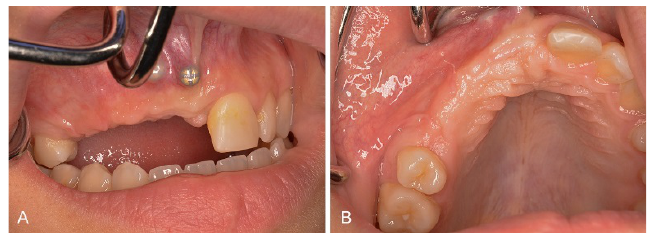
Figure 4. Clinical situation at six months after autogenous bone augmentation.